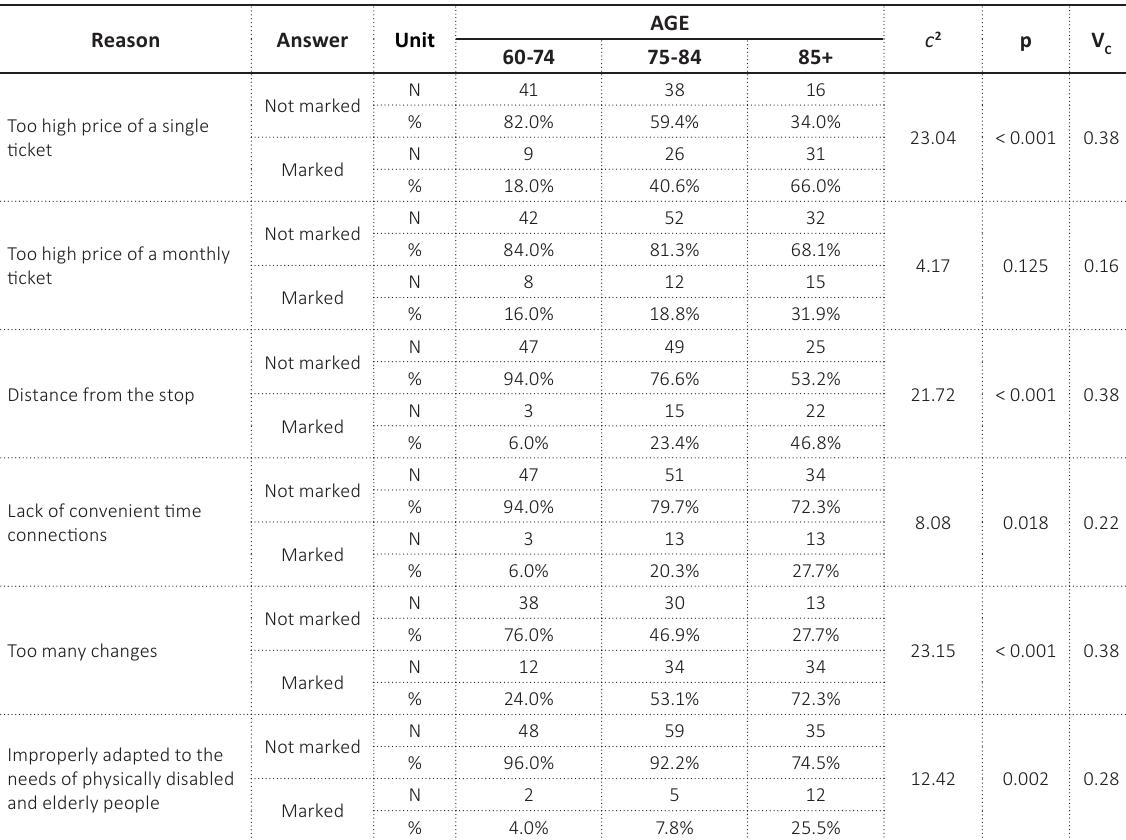
Table 3. The number and percentage of ticks of the answer “Why do you not use public transport?” depending on